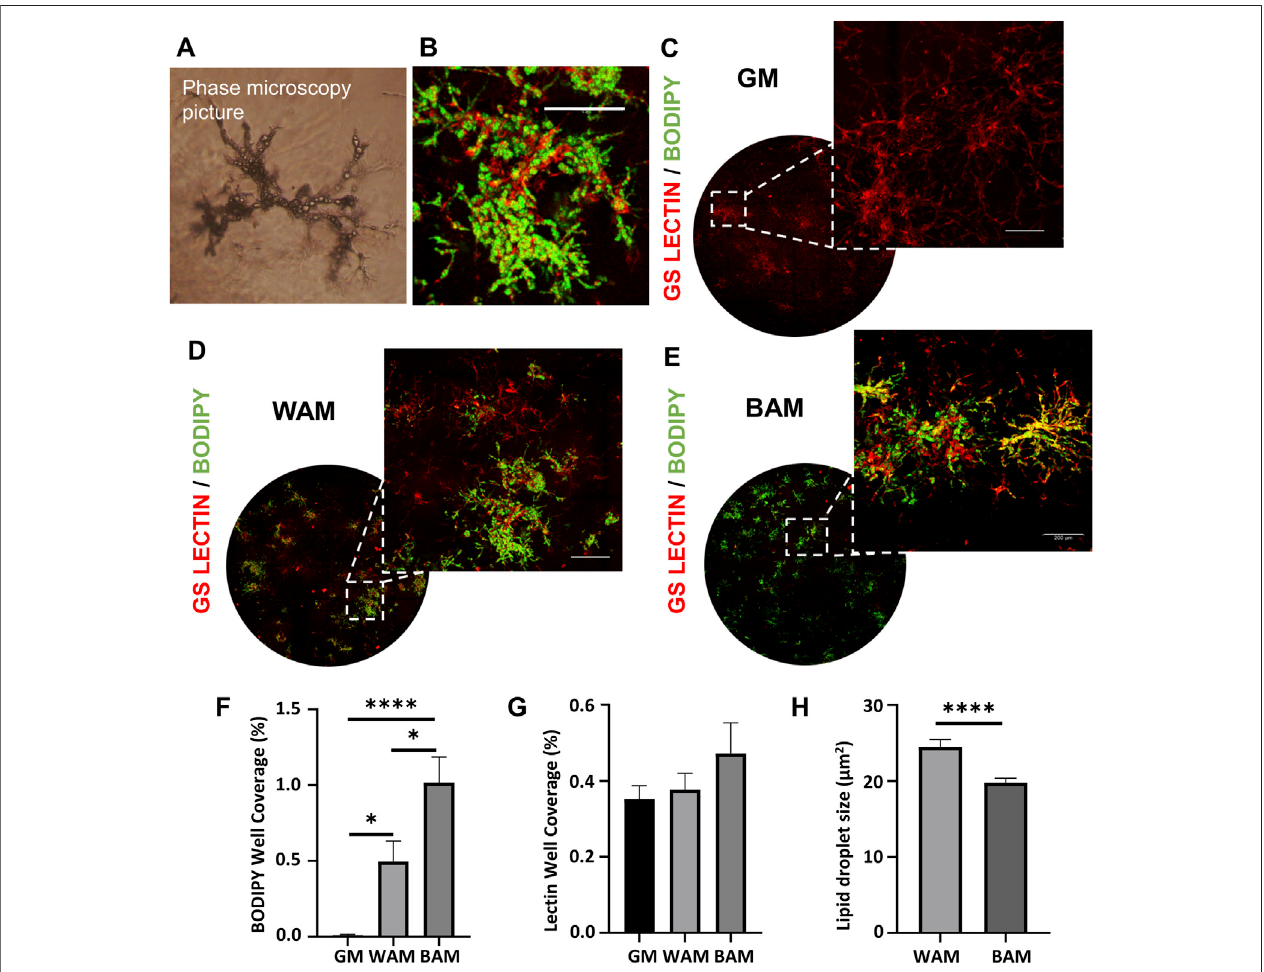
FIGURE 1 | Immuno fl uorescence analysis of human microvascular fragments (hMVFs) beige adipogenic differentiation after 14 days. (A) Representative phase microscopy image of hMVFs after differentiation. (B) Higher magni fi cation image of stained hMVFs (scale bar = 12 μ m). (C – E) Representative confocal images of hMVF grown in fi brin scaffolds and stained with GS-Lectin I (red) to visualize vascular network formation and BODIPY (green) to identify the presence of lipid droplets. The imagesontheleftmostsidedisplayanoverviewofthedistributionofthehMVFsintheentirewell(hydrogel),andthecorrespondinginsetsontherightwereincluded to visualize more clearly the presence of adipocytes and their interaction with the vessels (scale bars = 200 μ m). (F, G) Quantitative analysis of lipid and vessel formation as determined with BODIPY or lectin accumulation, respectively. (H) Quanti fi cation of the lipid droplet size. Results are reported as mean ± standard error ( n = 6). * = p < 0.05, ** = p < 0.01, *** = p < 0.001, and **** = p <